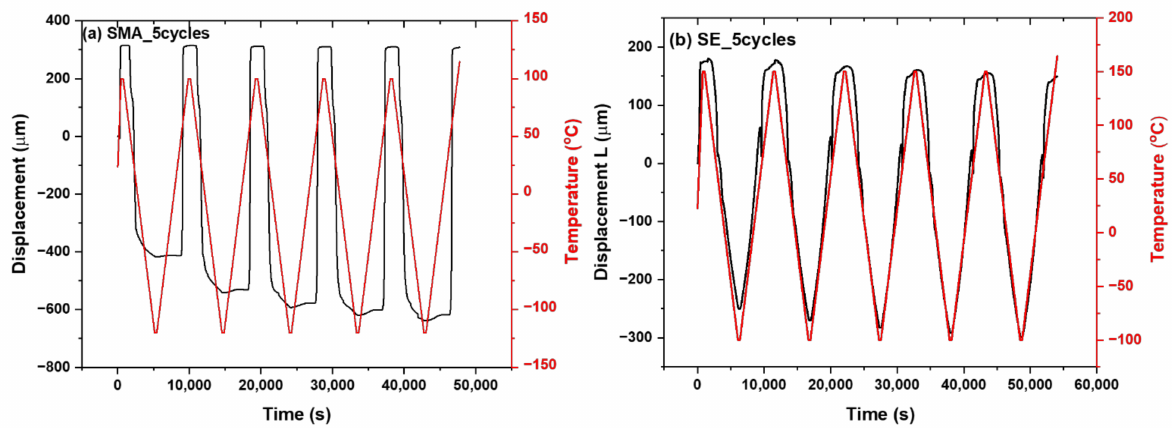
Figure 8. ( a , b ) Displacement and temperature profile for SMA and SE (5_cycles) as a function of